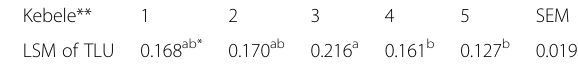
Table 2 Available feed and number of respondents on feed source usage